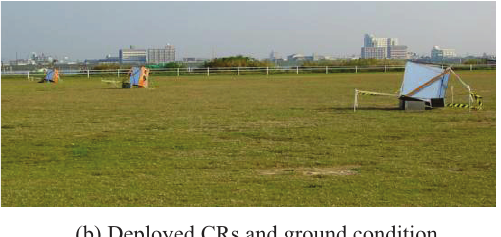
(b) Deployed CRs and ground condition. Figure 4. Observation experiment at the riverbed of Yoshino river, Tokushima, Japan.